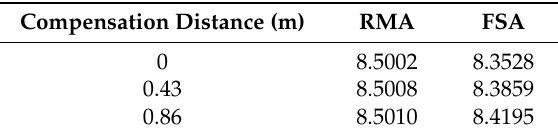
Table 3. Entropy of the front view images.